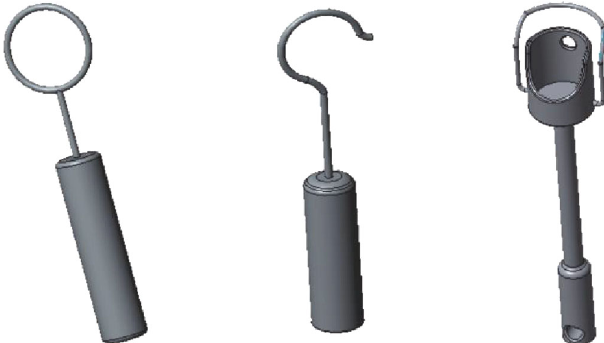
Figure 8: Di ff erent types of prosthesis for stapes injury.